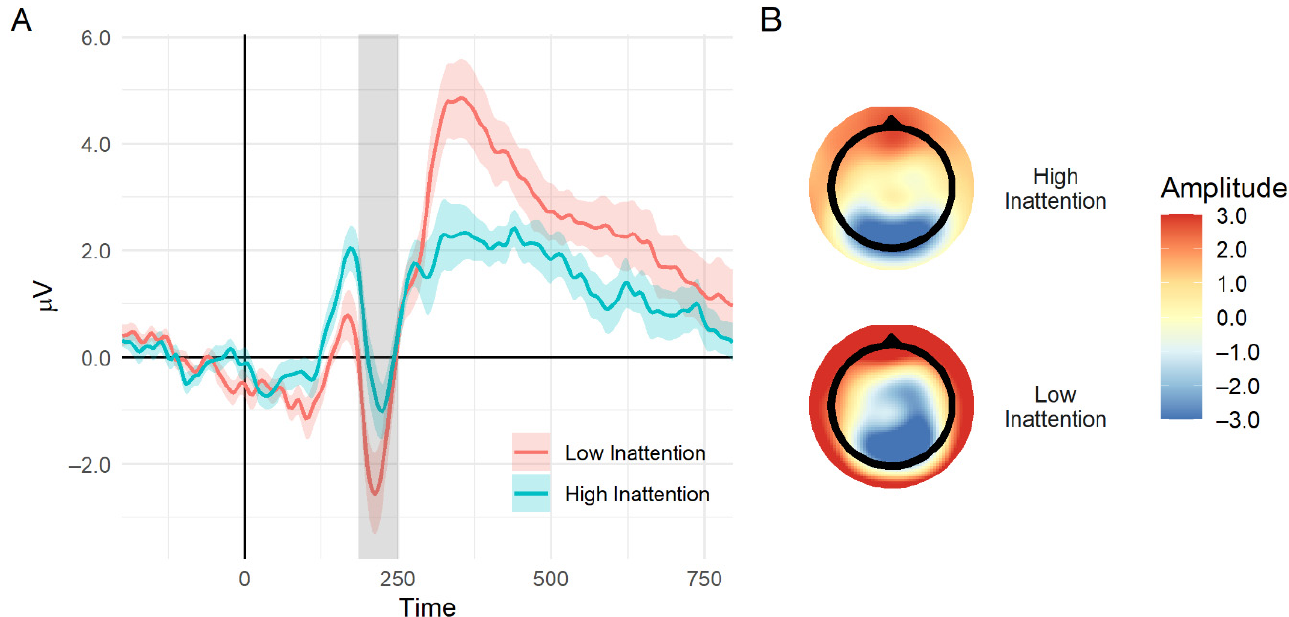
Figure 2. ( A ) An illustration of the event-related potential wave plot of the difference between a successful stop and successful slow go for adolescents with high and low concurrent inattention symptoms (group defined by the lower and upper quartile). The gray area delineates the N2 time window; the shaded area represents standard error. ( B ) Topographic maps of voltages on the scalp at the N2 time window (specifically at 200 ms after stop-signal presentation) for high (top) and low (bottom) concurrent inattention symptoms.